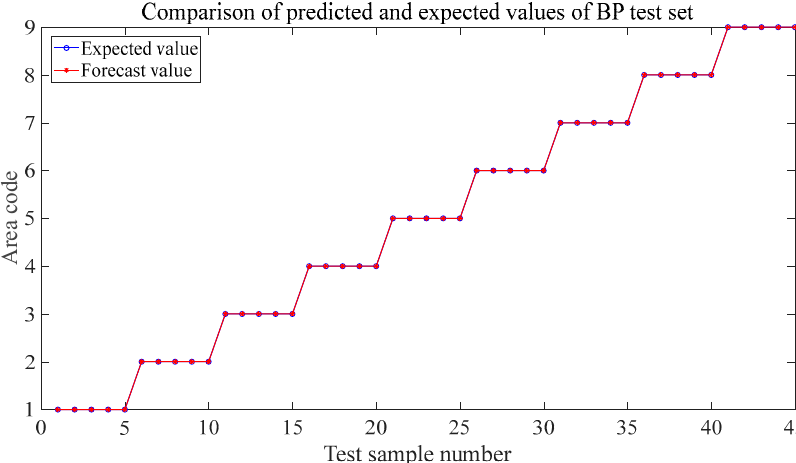
Figure 15. Predicted results when the center frequency is 200 kHz. Figure 16. Prediction results when the center frequency is shifted by 20 mm at 200